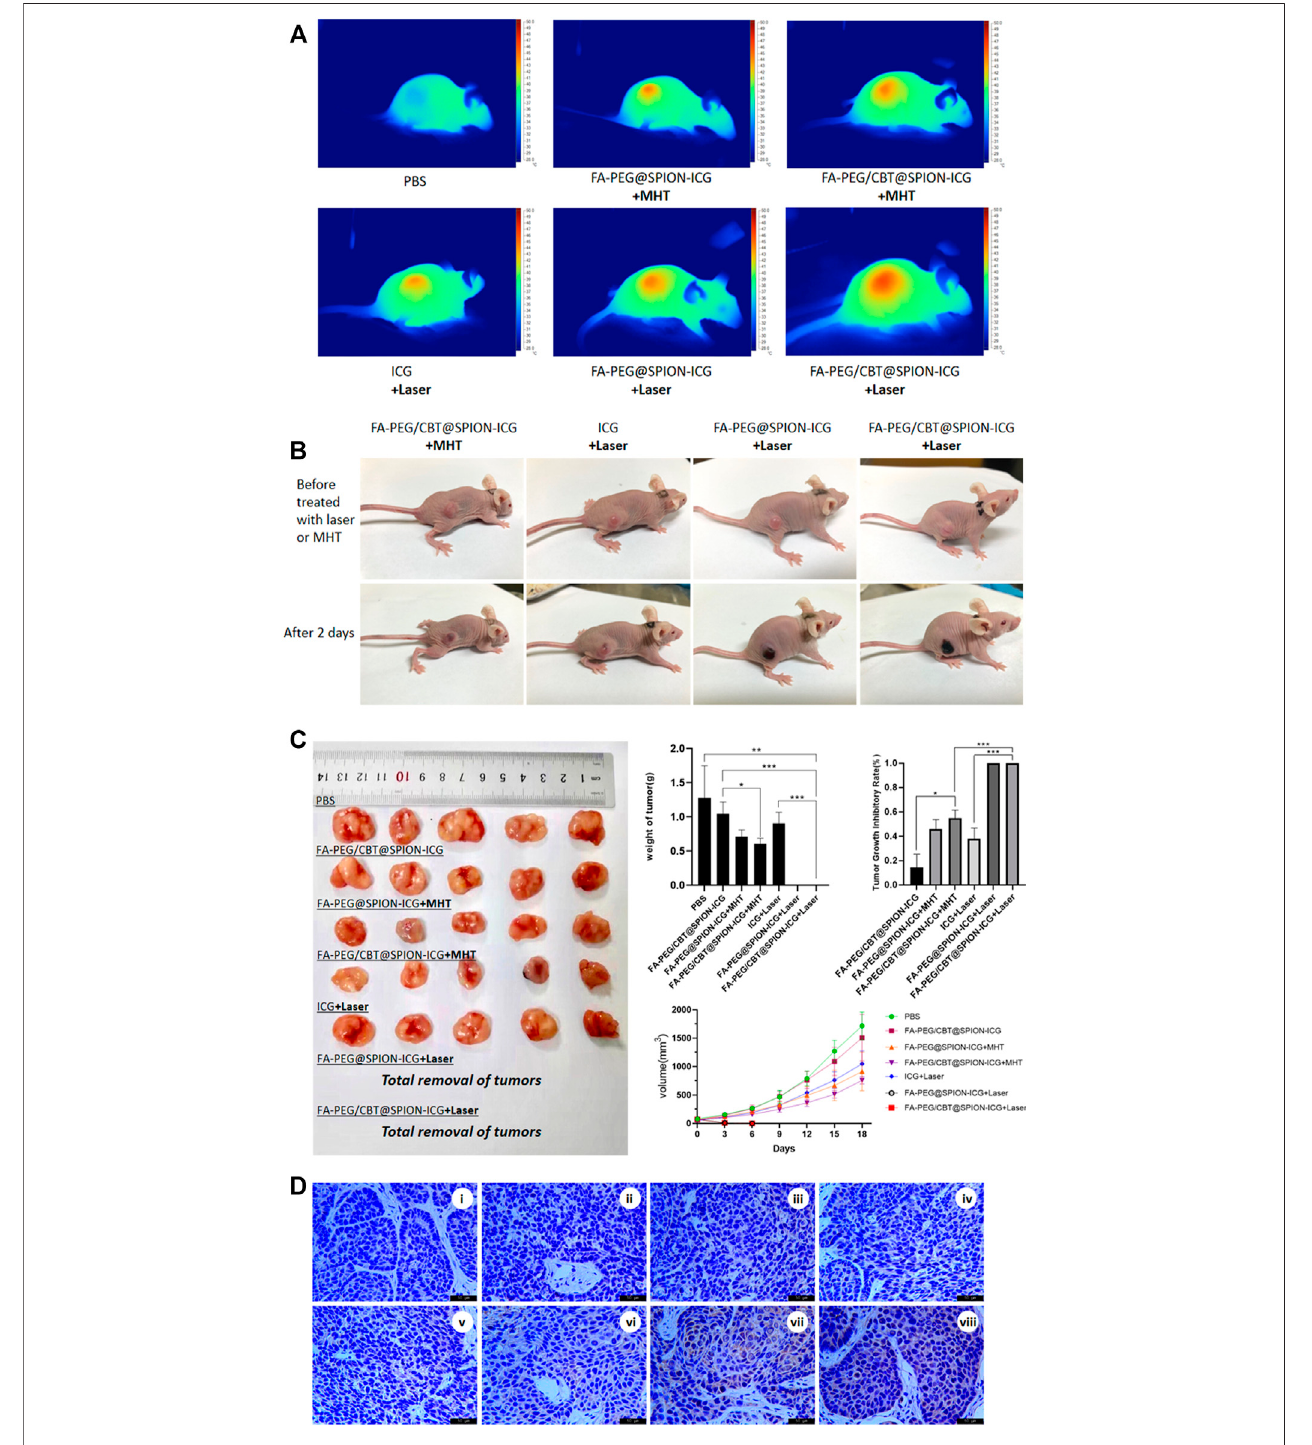
FIGURE 5 | Thermal imaging of the mice after treatment with different formulations with NIR or MHT (A) . Imaging was performed before and on day 2 after the different treatments (B) . Tissues dissected from nude mice, mass histogram ofthe tumor weight, mass histogram of the tumor growth inhibition rate, and a line graph of tumor tissuevolumeovertime (C) (N (cid:1) 5)(*) p < 0.05(**) p < 0.01(***) p < 0.001.ImmunohistochemicalanalysisofHsp70expressionindifferentgroups (D) . Figure4D ,i isPBS, iiisPBS+Laser,iii isFA-PEG/CBT@SPION-ICG, ivisFA-PEG@SPION-ICG +MHT, visFA-PEG/CBT@SPION-ICG +MHT,vi isfreeICG +Laser, viiisFA- PEG@SPION-ICG + Laser, and viii is FA-PEG/CBT@SPION-ICG + Laser.